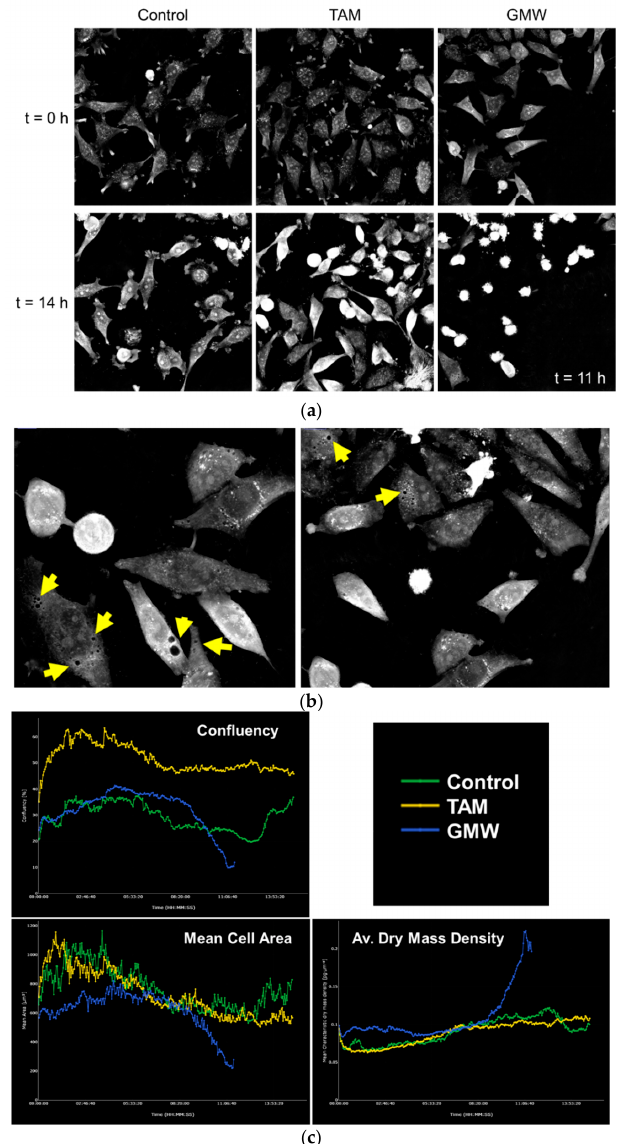
Figure 7. Live-cell imaging study on HeLa cells. ( a ) Representative images of the experiments for untreated (control) cells and cells exposed to 10 µM TAM or 100 µg/mL GMW. ( b ) Images of cell vacuolization after treatment with GMW for 5 h. Yellow arrows indicate cytoplasmic vacuoles observed. ( c ) Confluency, Mean Cell Area and Average Dry Mass Density obtained with STEVE software based on refractive indices resulting from CX-A observation over time. Green: untreated cells. Yellow: TAM (10 µM). Blue: GMW (100 µg/mL).